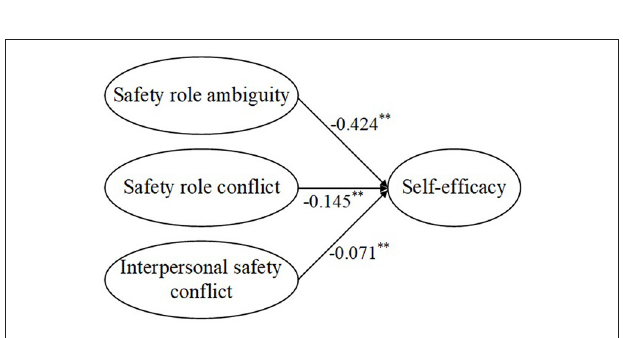
FIGURE 3 | Direct effects of safety stressors on ego depletion. ** p < 0.01.